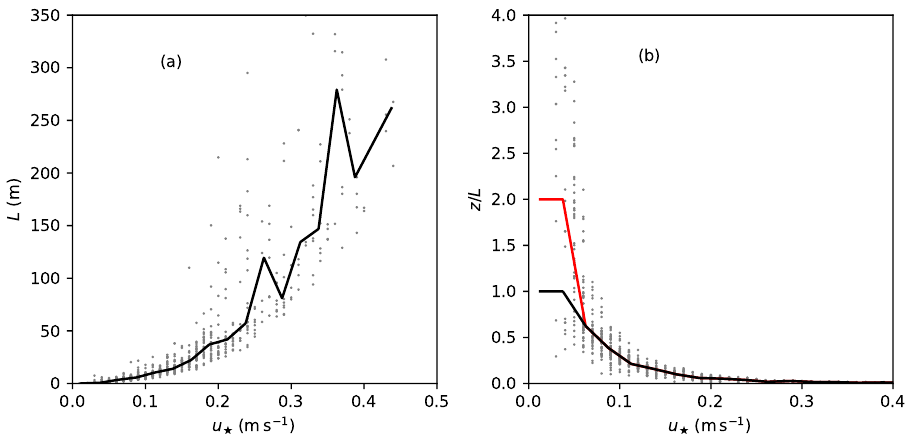
Figure 3. Obukhov length L ( a ) and stability parameter z / L ( b ) as functions of u (cid:63) at a 2.2 m height according to SHEBA observations. Solid lines represent the L and z / L values obtained using bin averaging of L for regular intervals of u (cid:63) .